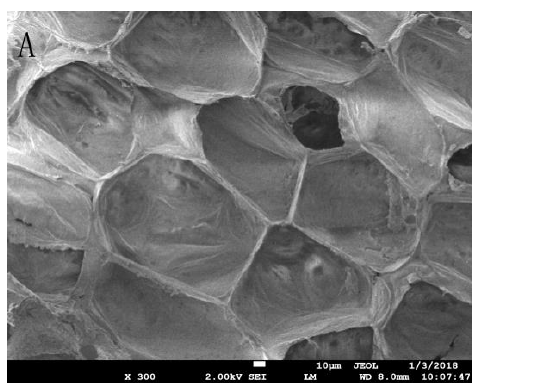
Table 2. Effect of APLTP treatment on sensory indicators of fresh-cut cucumber.